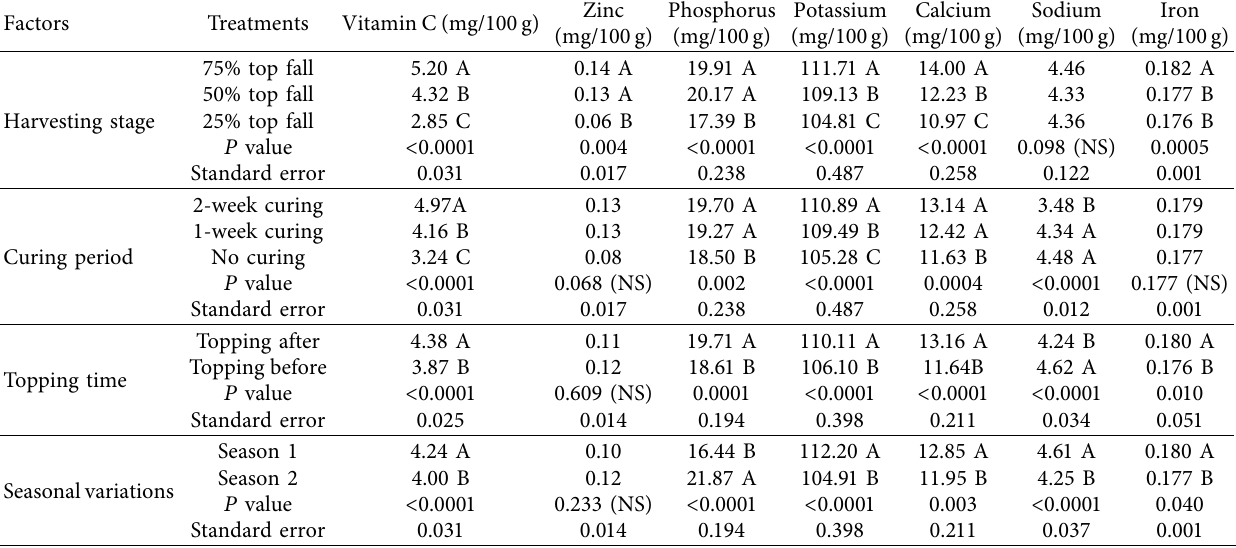
Table 3: Nutritional composition of stored bulb onions as affected by postharvest treatments.